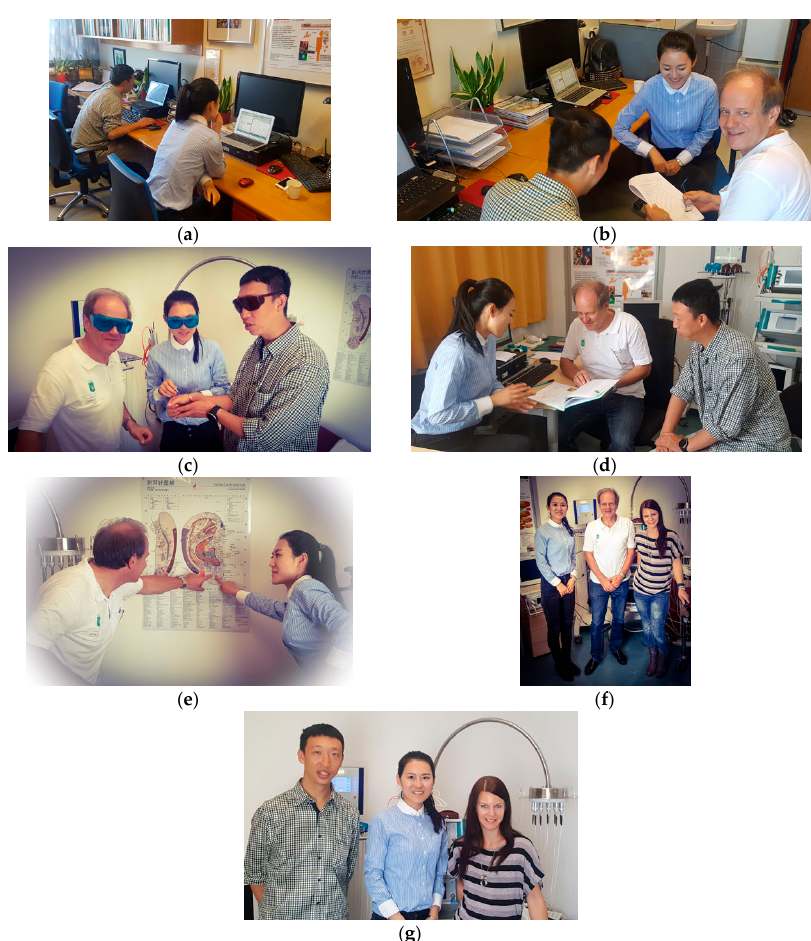
Figure 27. Project Cooperation: People’s Liberation Army General Hospital, Beijing University of Chinese Medicine, and Medical University of Graz ( a – g ). ( d ) From left to right: Huan Wang, MM (People’s Liberation Army General Hospital), Professor Gerhard Litscher, and Dr. Li Guangzong (Beijing University of TCM). ( g ) From left to right: Dr. Li Guangzong, Huan Wang, MM, and Dr. Daniela Litscher. 17 October 2017. Hilton, Xi’an, China, 380 participants, Report published in Medicines [10].